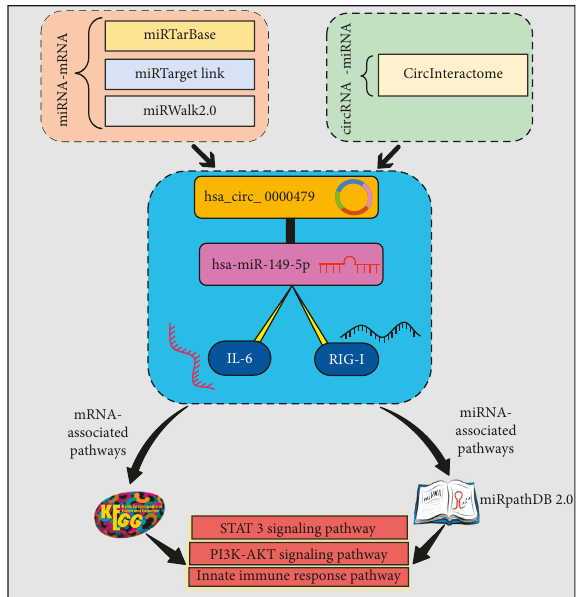
Figure 4: A schematic representation of a workflow for bio- informatics